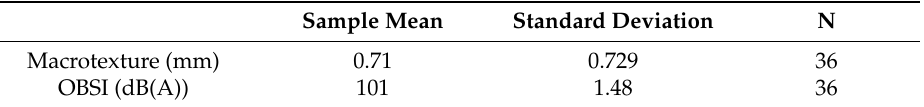
Table 6. Statistical description of macrotexture and OBSI of longitudinal groove